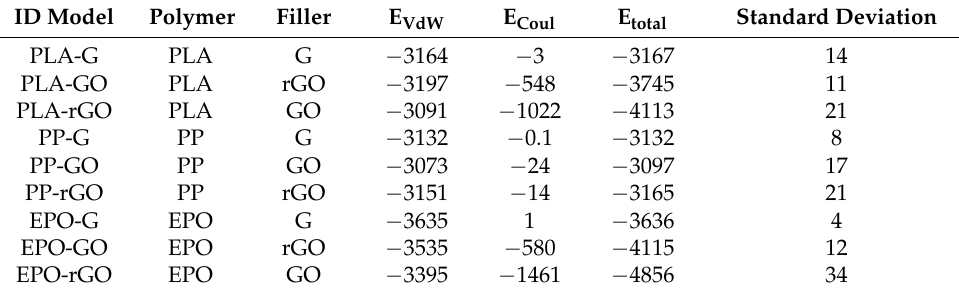
Table 2. Interaction energies (in